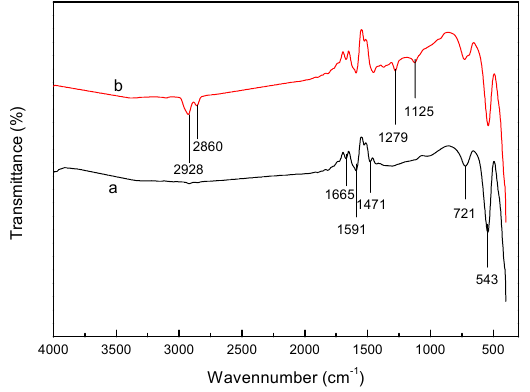
Figure 1. FT-IR spectra of (a) α -MnO 2 nanorods and (b) BISIN.